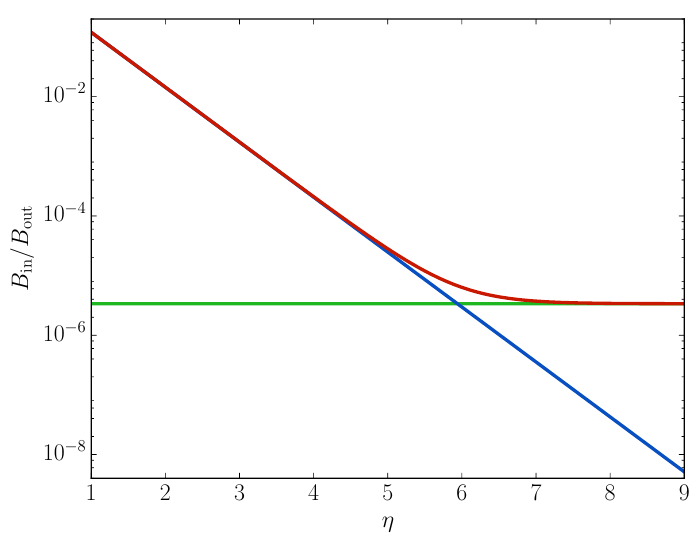
Figure 2 . Comparing the classical (blue) transmission to the expected fermion signal (green) and their sum (red), using q = 0 : 3 and md = 1 : 5, as a function of (cid:17)